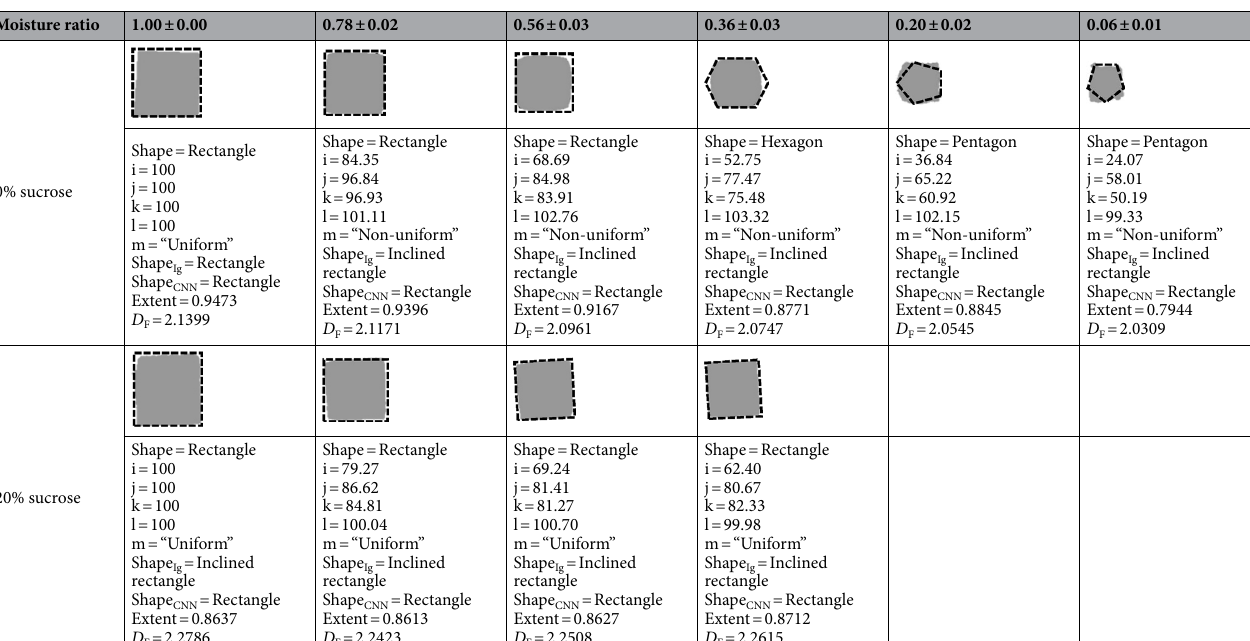
Table 2. Top-view images of agar cubes with 0 and 20% sucrose during drying at 80 °C. Shape CNN was that obtained via CNN Xception.